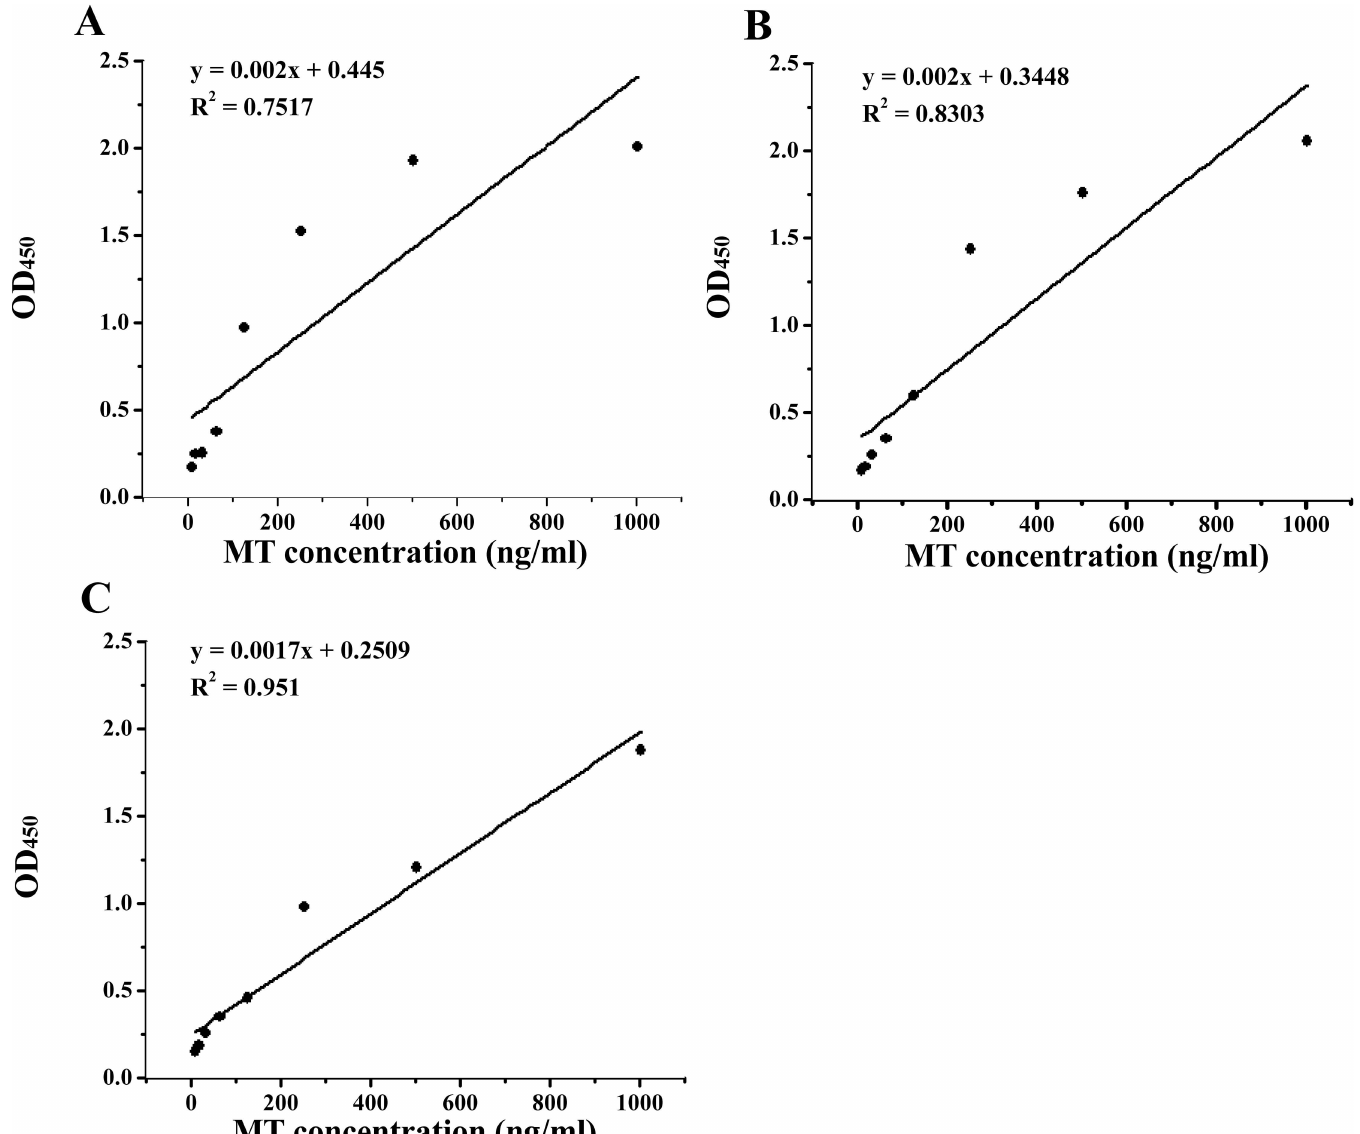
Fig 3. Regressioncurve of ELISA betweenMT concentration and OD 450 with 1:120000(A), 1:140000(B), and 1:160000(C) dilutionof MT anti-serum.